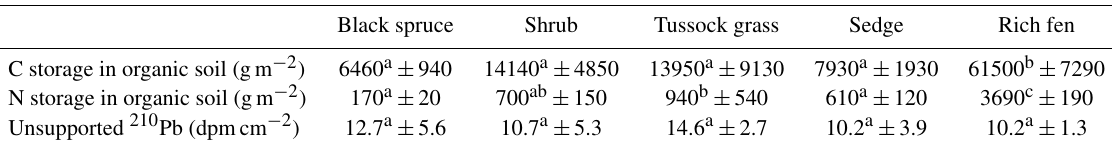
Table 2. Site C (gm − 2 ) , N (gm − 2 ) , and Unsupported 210 Pb (dpmcm − 2 ) storage data. Unsupported 210 Pb inventories represent the total atmospheric input of 210 Pb to that site. Data are averages of three cores with standard deviations. Different letters after values indicate that the values among ecosystems are statistically different based on the Tukey Honest Significant Difference test. Black spruce Shrub Tussock grass Sedge Rich fen C storage in organic soil (gm − 2